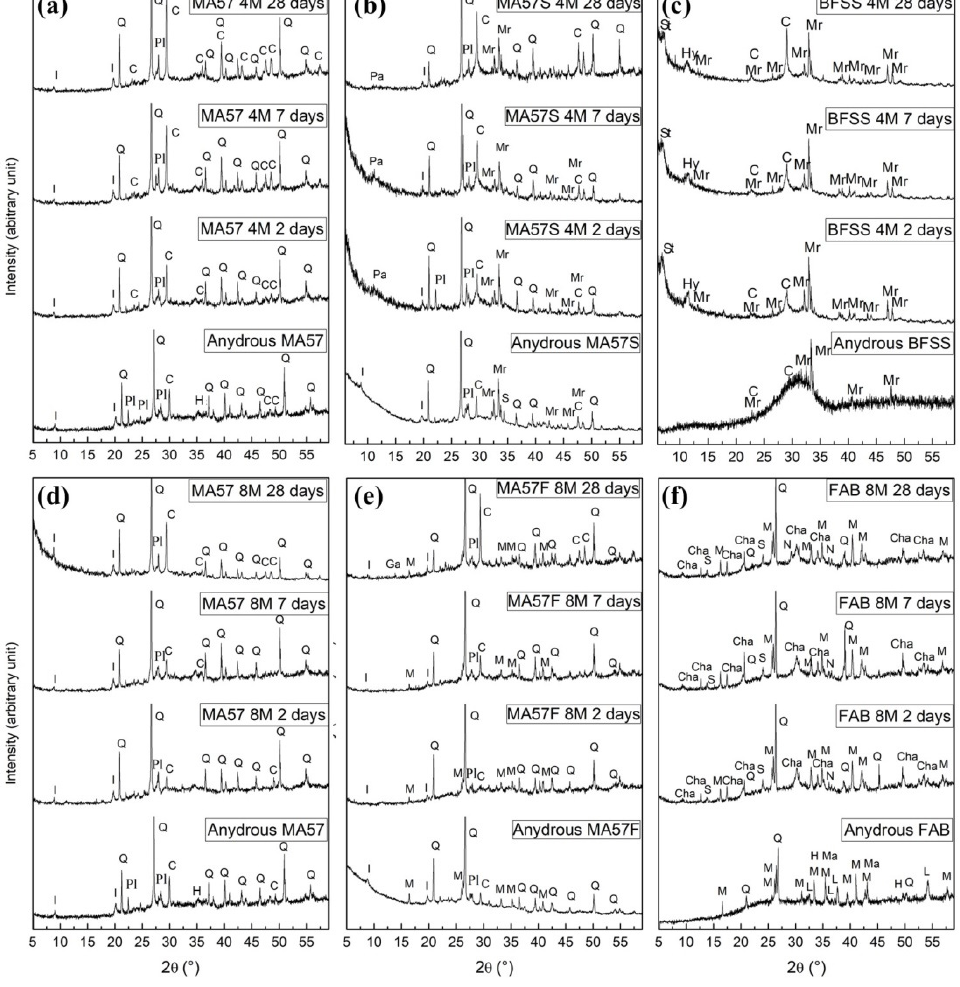
Figure 4. XRPD patterns of precursors (in the bottom part of each panel) and alkali activated pastes detected at 2, 7 and 28 days of curing: ( a ) MA57_4M, ( b ) MA57S_4M, ( c ) BFSS_4M, ( d ) MA57_8M, ( e ) MA57F_8M and ( f ) FAB_8M. Legend: C = calcite (PDF# 00-005-0586; PDF# 01-083-0577); Ga =